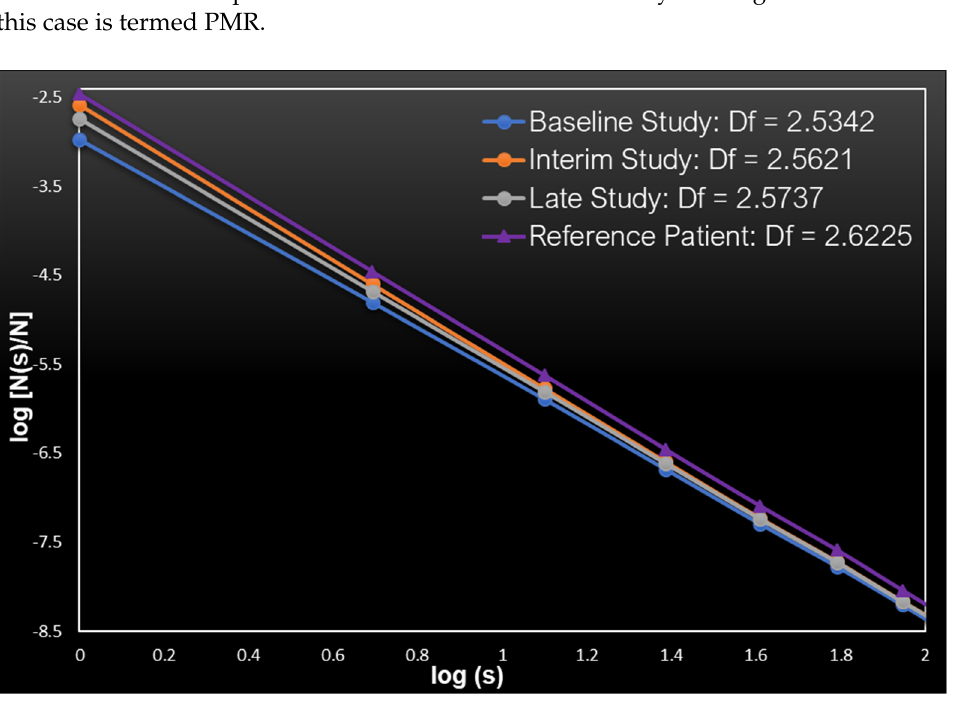
Figure A1. The normalized number of boxes N(s)/N which contain the tracer as a function of the box size s in a double logarithmic scale for patient P10, whose clinical diagnosis was PMR. The blue line corresponds to the baseline study of patient P10, the orange line to the interim study and the gray line to the final study of the same patient. For comparison, the purple line representing healthy control H3, is also depicted.